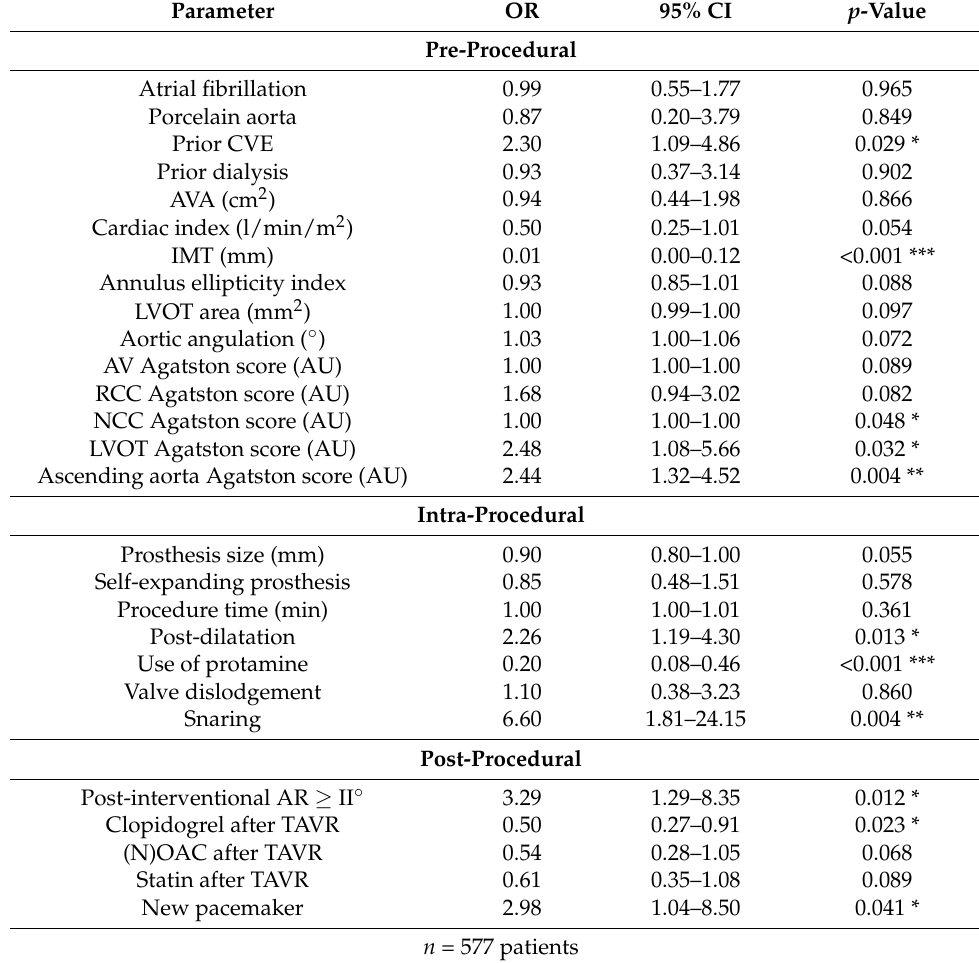
Table 1. Univariate logistic regression of pre-procedural, intra-procedural, and post-procedural parameters. Parameter OR 95% CI p -Value